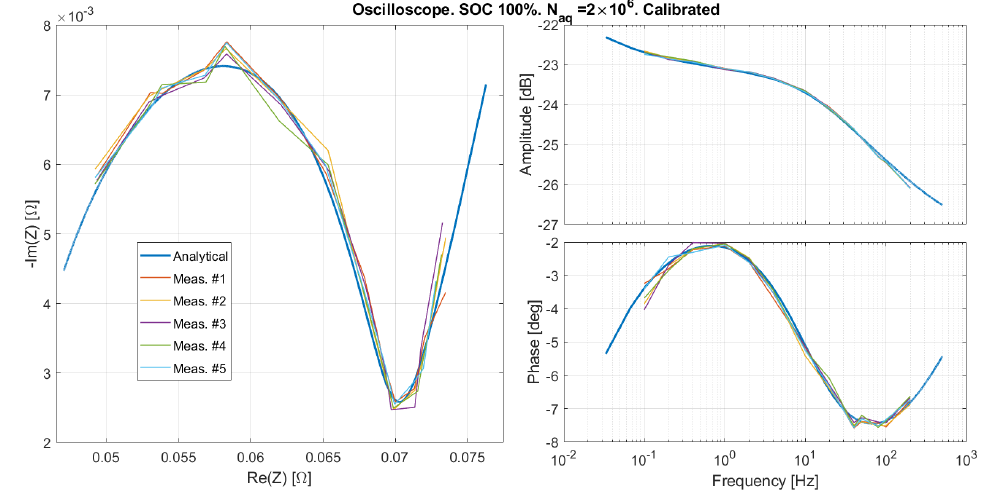
Figure 13. The emulated impedance as measured by means of a bench oscilloscope after the calibra- tion illustrated in Section